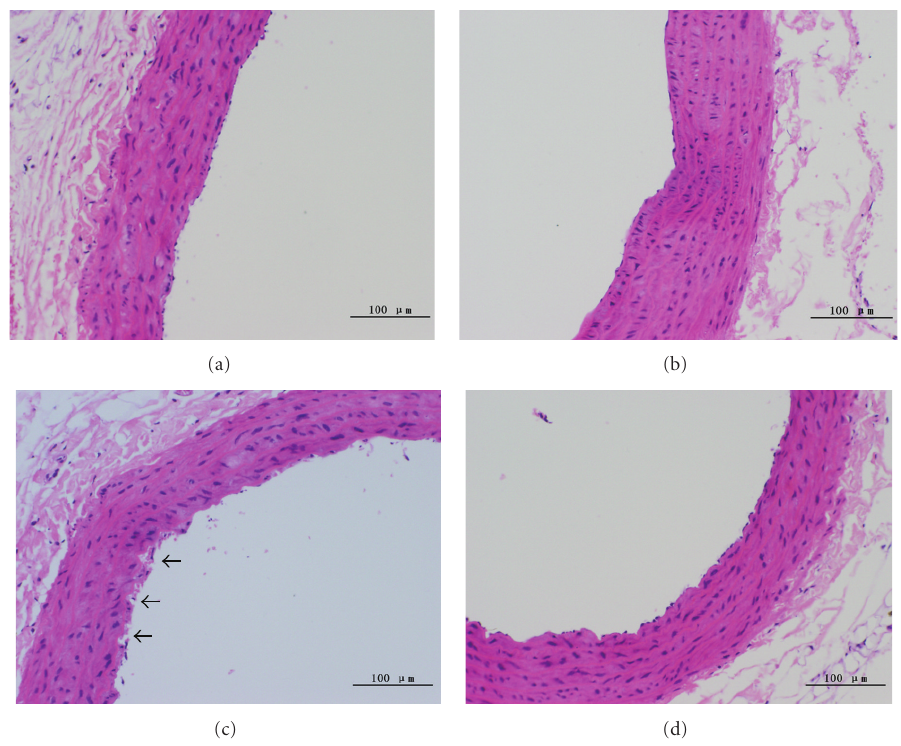
Figure 3: E ff ect of genistein on thoracic aorta morphological changes examined by HE staining ( × 100). (a) Con; (b) Met; (c) OVX + Met; (d) OVX + Met + GST . The tunica intima in OVX + Met group was seriously impaired with plenty of endothelial cell degenerated and desquamated from the wall (showed by ↑ ). Genistein could significantly improve the morphological changes of endothelium in ovariectomized HHcy rats. The tunica intima in OVX + Met + GST group was almost intact. Smooth muscle cells did not show any di ff erence among di ff erent